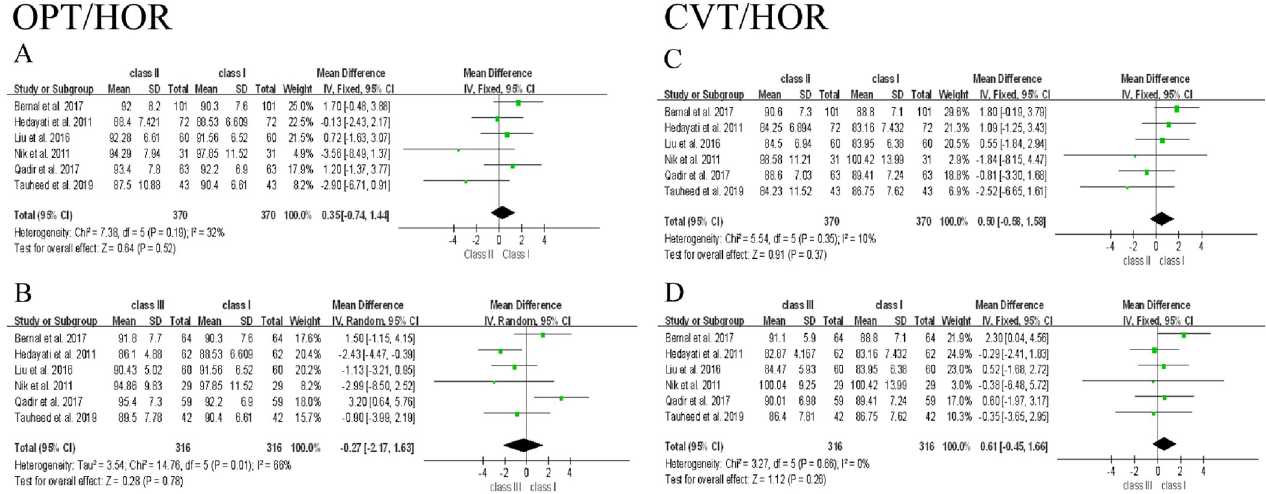
Fig 3. Forest plot of the association between cervical inclination and Class I, II, and III malocclusion.